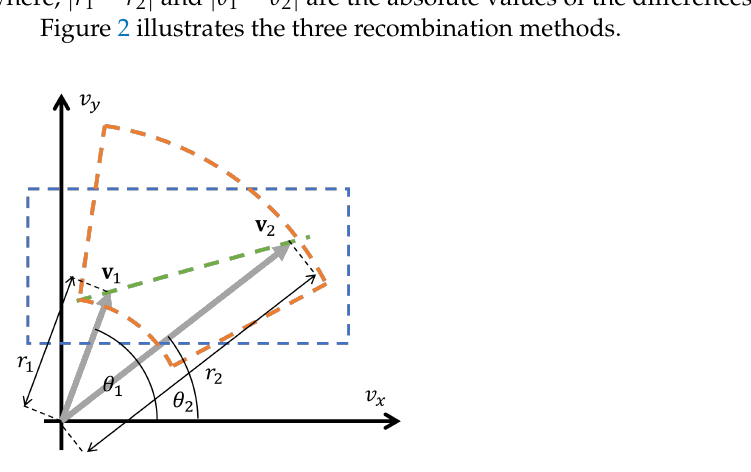
Figure 2. Illustrating the three recombination techniques for the velocity vectors v 1 and v 2 . The green line shows the possible outcomes of the linear recombination, the blue area shows the possible endpoints of the intermediate recombination, while the orange area shows the possible endpoints of the polar coordinate recombination